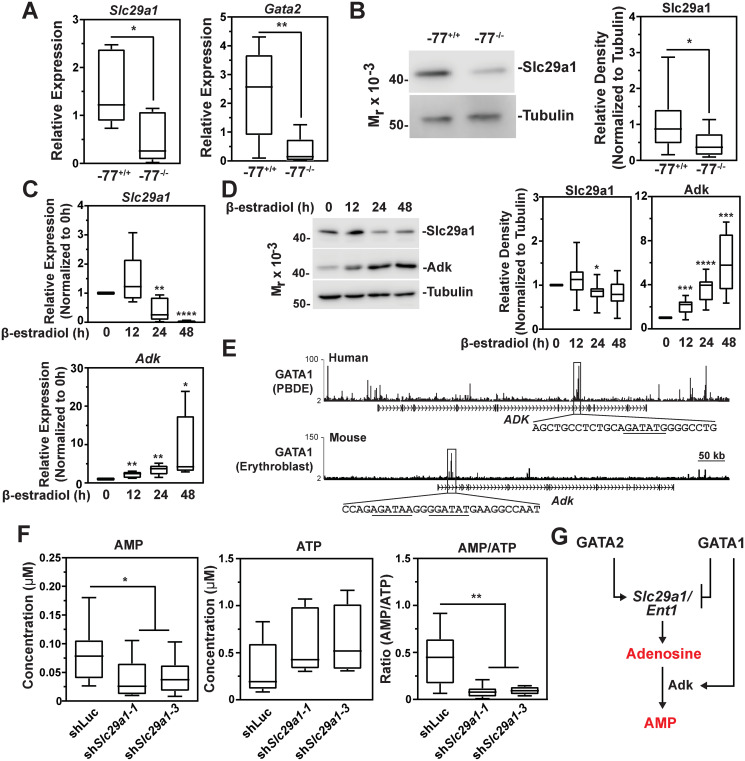
GATA factor regulatory circuit links Slc29a1 with adenosine mechanisms.(A) qRT-PCR analysis of Slc29a1 (left) and Gata2 (right) mRNA from Gata2–77+/+ and -77-/- HSPCs isolated from E14.5 fetal liver (n = 10). (B) Representative Western blot analysis to detect Slc29a1 protein in Gata2–77+/+ and -77-/- murine HSPCs isolated from E14.5 fetal liver (left). Quantification of relative band intensities from the immunoblots (n = 10; right). Tubulin served as a loading control. (C) qRT-PCR analysis of Slc29a1 (top) or Adk (bottom) mRNA isolated from untreated vs β-estradiol-treated (12, 24, or 48 hours) G1E-ER-GATA1 cells. (D) Representative Western blot analysis to detect Slc29a1 and Adk protein levels in untreated vs β-estradiol-treated (12, 24, or 48 hours) G1E-ER-GATA1 cells (left). Quantification of relative band intensities from the immunoblots (right). Tubulin served as a loading control. Statistical significance was determined by comparing values at 12, 24, or 48-hour times to those from untreated cells (0 hour). Data are from 4 separate experiments (n = 9). (E) ChIP-seq profiles of GATA1 occupancy at human (GEO GSE32491; PBDE) ADK and murine (GEO GSE30142; Ter119+ erythroblast) Adk loci [40, 47]. The underlined sequences denote WGATAR motifs. (F) AMP and ATP concentrations quantified by a luciferase-based assay in primary erythroblasts infected with shRNA targeting luciferase or Slc29a1 (left two panels). AMP/ATP ratio calculated from AMP and ATP concentrations (right). Data are from 4 separate experiments (n = 8). (G) Diagram depicting the relationships between GATA2, GATA1, Slc29a1, and Adk. For the box-and-whisker plots, the box depicts the 25th to 75th percentiles of data, the median line, and whiskers ranging from minimum to maximum values. Statistical analysis was carried out using an unpaired 2-tailed Student’s t test. * p < 0.05, ** p < 0.01, *** p < 0.001, **** p < 0.0001.